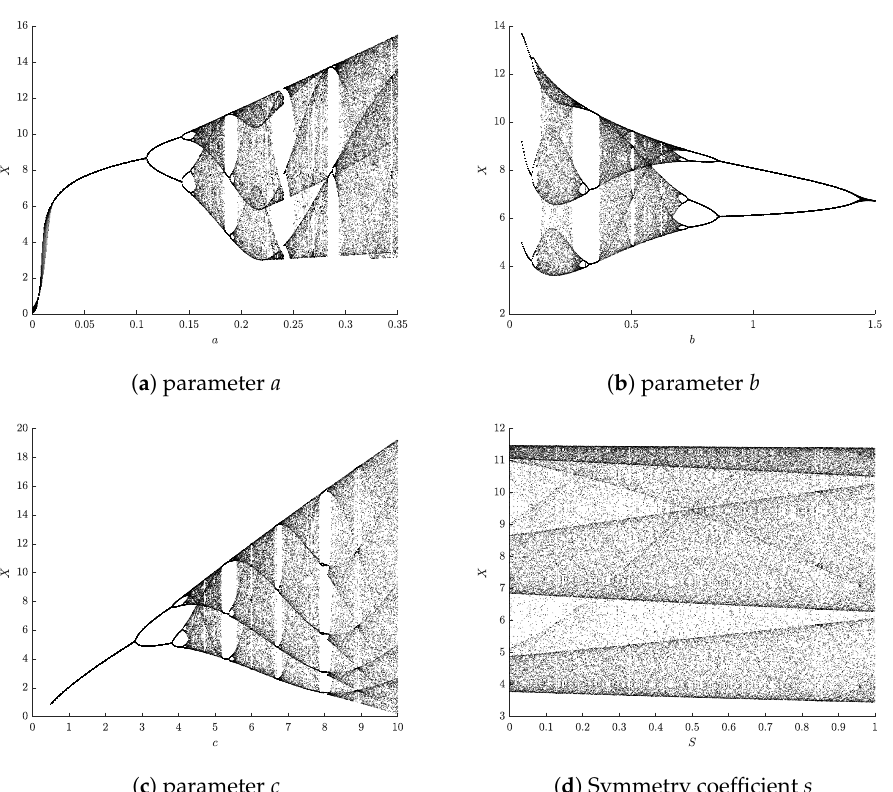
Figure 8. Bifurcation diagrams for Rössler system simulated with h = 0.01 s.